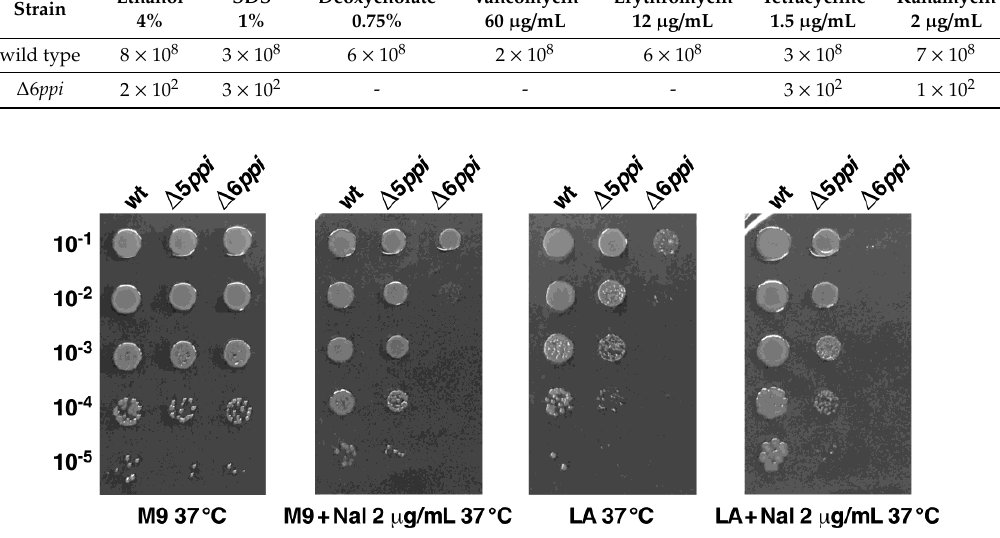
Figure 2. ∆ 6 ppi bacteria exhibit the sensitivity to nalidixic acid (Nal) on either M9 minimal medium or Luria Agar (LA) medium. Exponentially grown cultures of the wild type and its isogenic ∆ 5 ppi and ∆ 6 ppi derivatives were adjusted to an optical density OD 600 of 0.1 and serially spot diluted on M9 minimal medium and LA medium with or without supplementation with 2 µ g / mL Nal. Plates were incubated at 37 ◦ C for 24 h. Data presented are from one of the representative experiments.